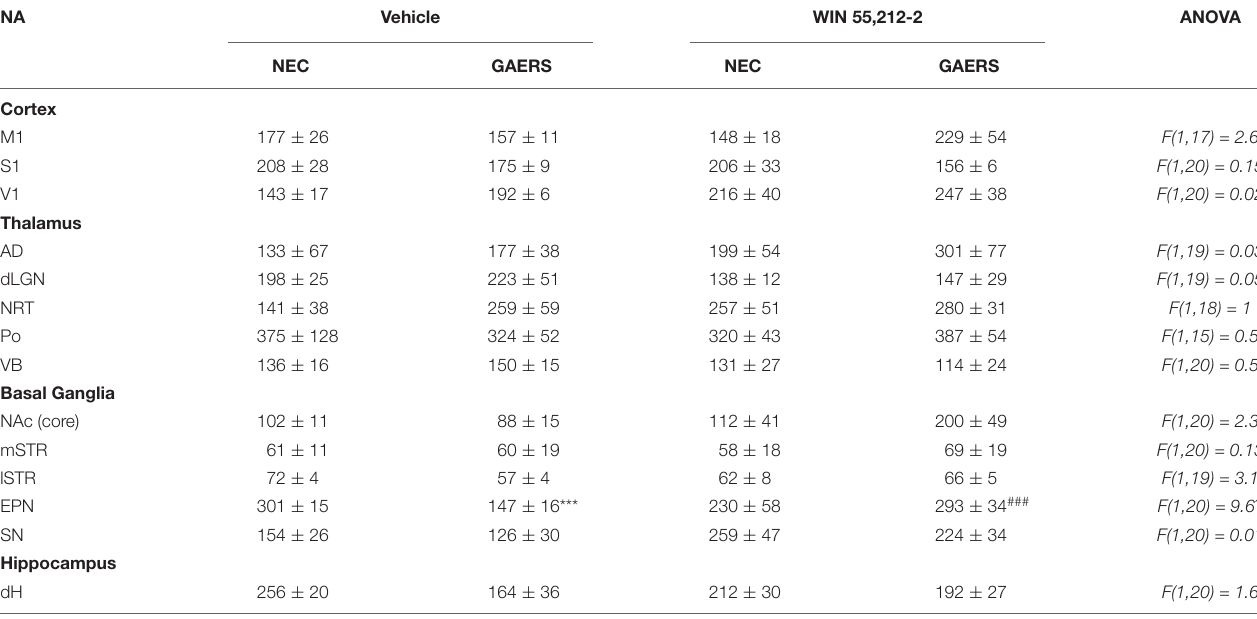
TABLE 1 | Effect of WIN 55,212-2 and its vehicle on Noradrenaline (NA) levels in selected brain areas of Genetic Absence Epilepsy Rats from Strasbourg (GAERS) and non-epileptic control (NEC) rats. NA Vehicle WIN 55,212-2 ANOVA NEC GAERS